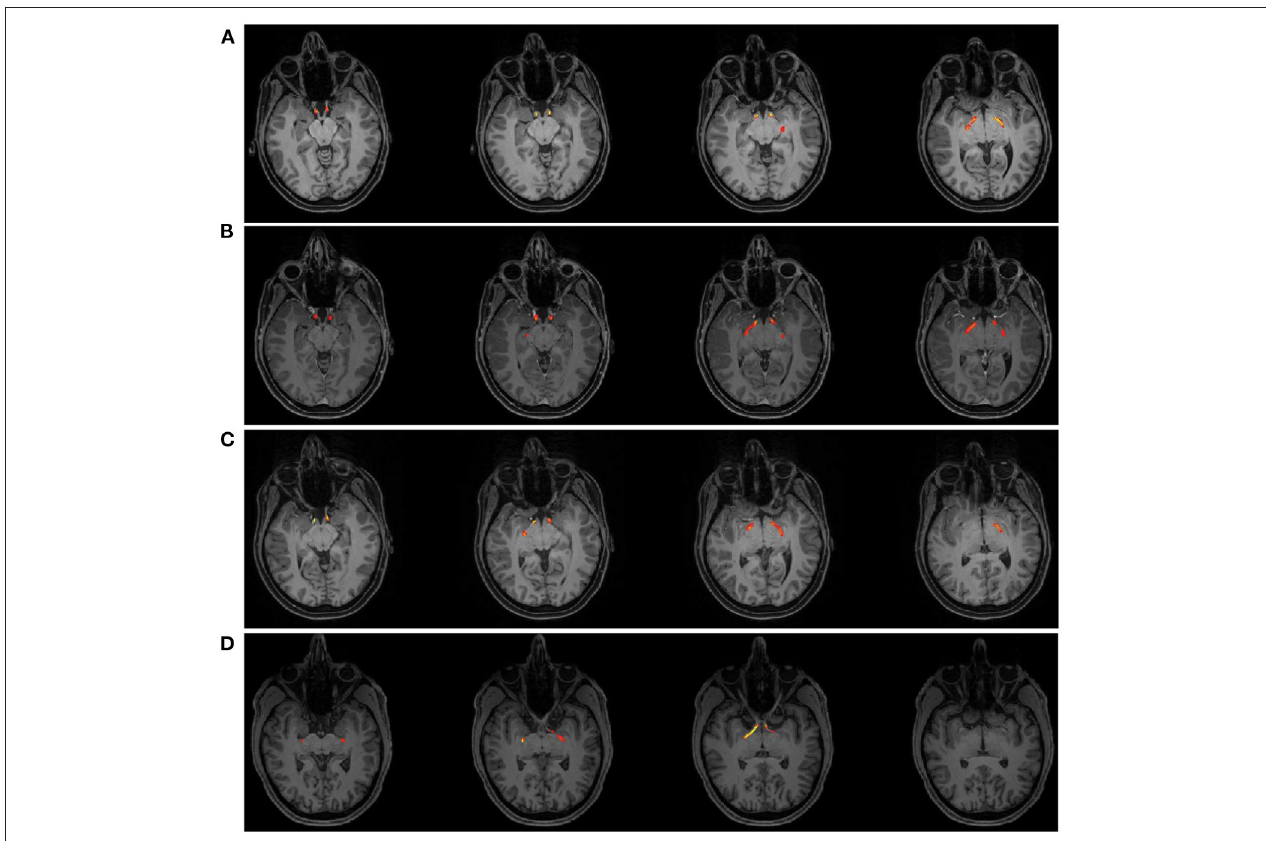
FIGURE 4 | Tractography Results of the optic tract for patient AJ at each time point; (A) AJ1, (B) AJ2, (C) AJ3, and for a representative control participant (D) demonstrating the course of the optic tract from just posterior the chiasm to the lateral geniculate nucleus. Supplementary Figure 3 shows tractography results for each control